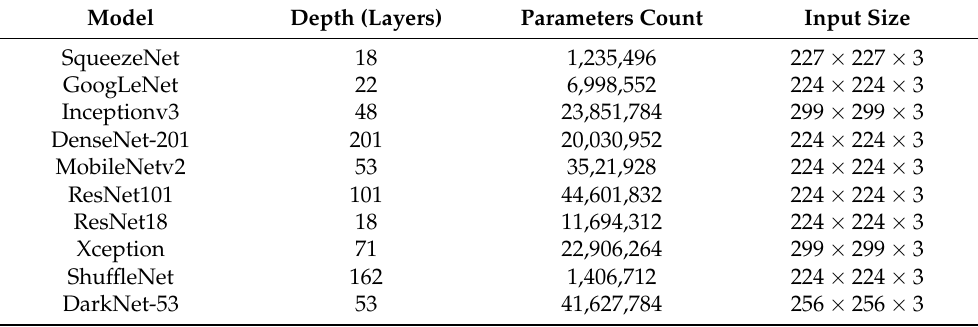
Table 1. The depth in terms of number of layers, the number of parameters, and the required input size for each model. Model Depth (Layers) Parameters Count Input